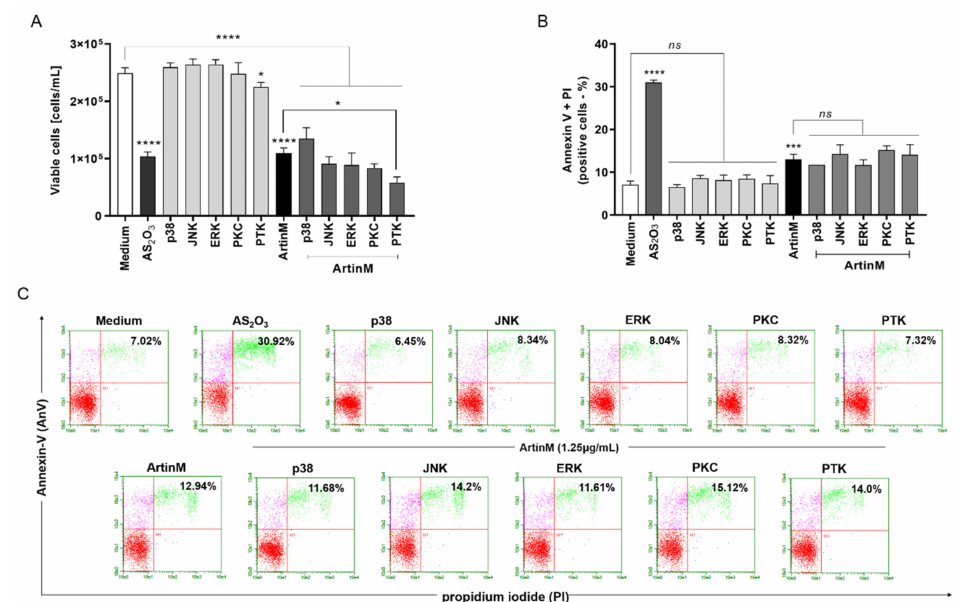
Figure 7. Pharmacological inhibition of the signaling molecules p38, JNK, ERK, PKC, or PTK does not affect ArtinM-induced apoptosis of Raji cells. Raji cells (1 × 10 5 cells/mL) were seeded in 96- well microplates and pre-treated or not with pharmacological inhibitors (20 µ M), such as SB202190 (p38MAPK inhibitor), SP600125 (JNK inhibitor), PD98059 (ERK inhibitor), H-7 (PKC inhibitor) and genistein (PTK inhibitor). After 210 min, the cells were stimulated with ArtinM (1.25 µ g/mL) for 24 h at 37 ◦ C. Arsenic trioxide (AS 2 O 3 ; 12 µ M) was used as a positive control of cell death induction, and the medium alone was used as a negative control (Medium). ( A ) The number of viable cells (cells/mL) was determined as the difference between the total number of cells and PI+ cells (dead cells), detected by flow cytometry. The results are expressed as mean ± standard error of three independent experiments in triplicates. ( B , C ) The relative frequency of apoptotic cells was determined by annexin V-FITC (5.0 µ g/mL) and PI (10.0 µ g/mL) staining; double-positive cells (AnV+/PI+) were detected by flow cytometry analysis, and their relative frequency was represented as a percentage. Values with significant differences in relation to the medium or cells stimulated only with ArtinM are shown by *, p < 0.05; ***, p < 0.001; ****, p < 0.0001. ns: not